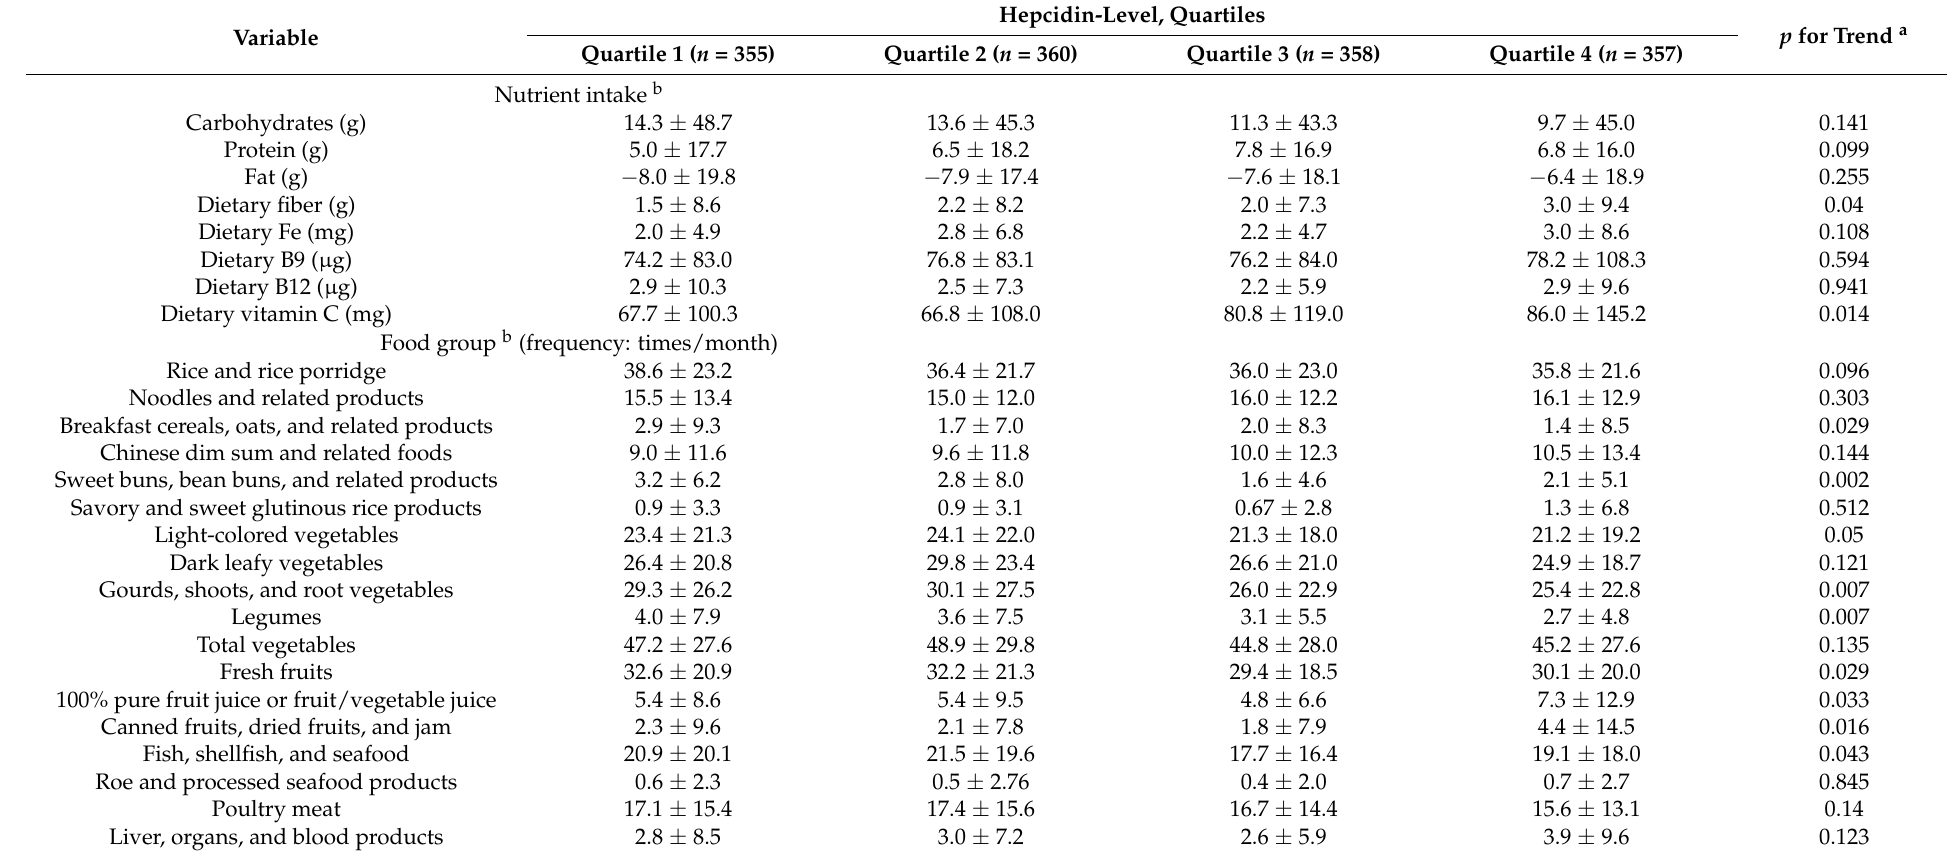
Table 2. Nutrient and food intake frequencies among pregnant women according to quartile levels of serum hepcidin ( N =